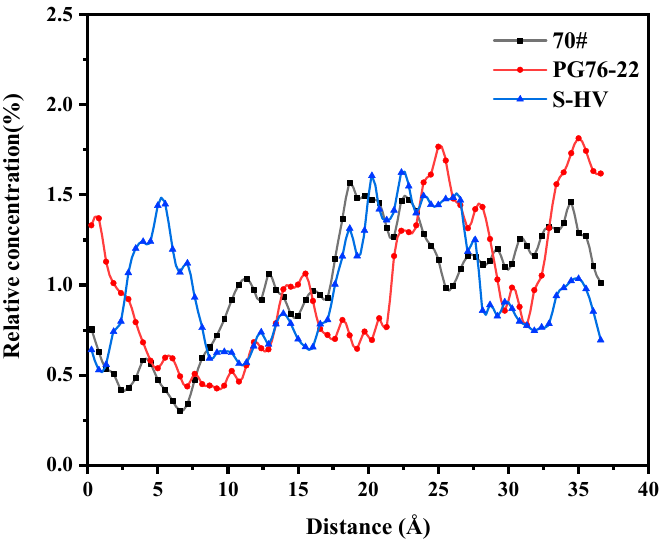
Figure 13. Solubility distribution of resins. As shown in Figure 14, the solubility of asphaltenes in PG76-22 modified asphalt had the greatest difference from those of S-HV and PG76 modified asphalts. The maximum value of asphaltenes appeared in the range of 15 Å to 20 Å and the solubility of asphaltenes at both ends was low, indicating that asphaltenes presented aggregation behavior in the middle. Relatively speaking, the distribution of asphaltenes in 70# and S-HV modified asphalts was more